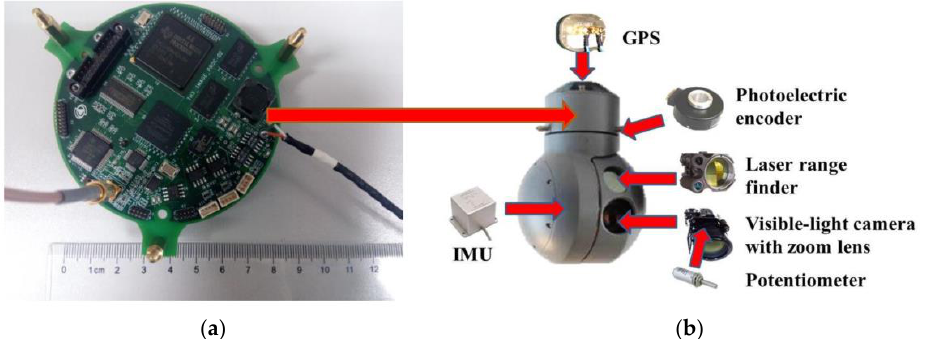
Figure 1. ( a ) Multi-target geo-location and tracking circuit board; ( b ) Electro-optical stabilized imaging system. The arrows in the Figure 1b represent the installation locations of main sensors in an electro-optical stabilized imaging system.